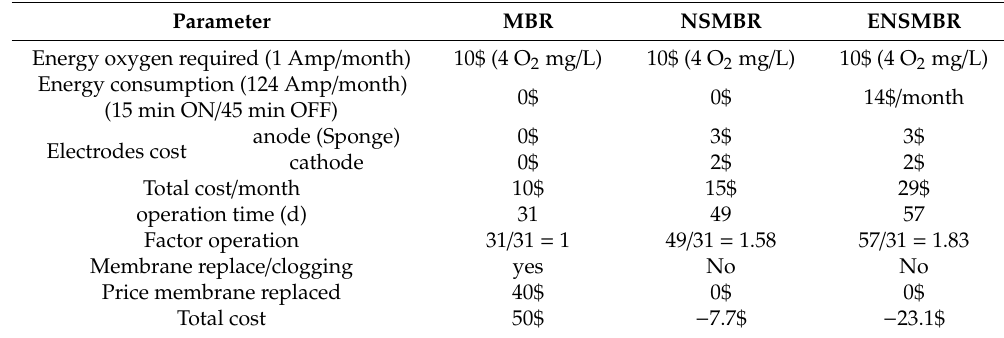
Table 5. Capital cost di ff erences among the MBR, NSMBR, and ENSMBR.